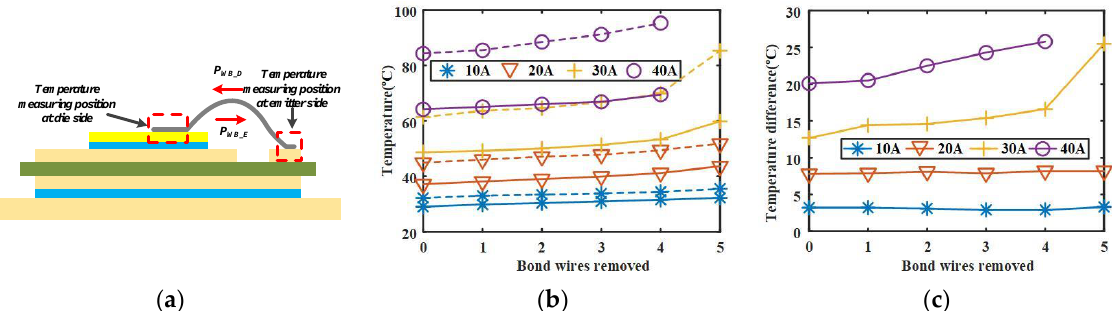
Figure 15. ( a ) Temperature measuring positions of bond wires two sides ( b ) Measured temperature of bond wires two sides ( c ) Temperature difference between two sides of bond wires.